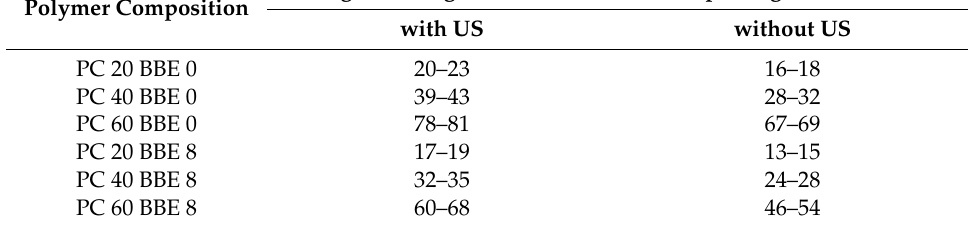
Table 10. Change in relative elongation at break of composite polymeric materials (PC) containing birch bark extract (BBE), received with (with US) and without the use of ultrasonic treatment (without US). Change in Elongation at Break after Composting for 6 months, % Polymer Composition with US